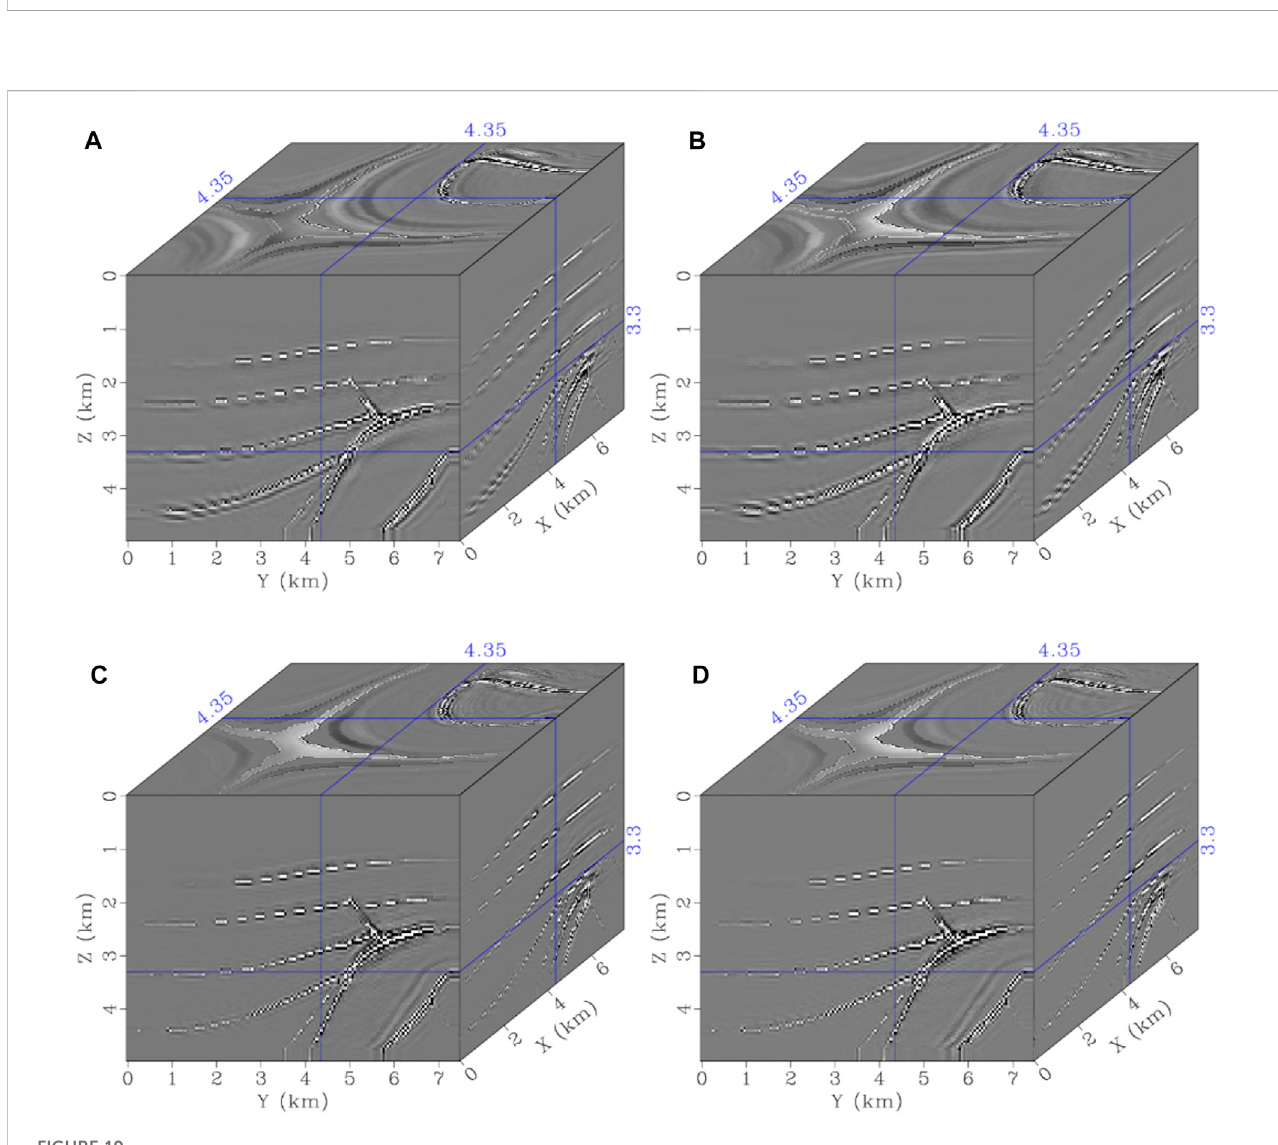
FIGURE 19 (A) and (B) PP and PS images using the STS method and (C) and (D) PP and PS images using the FTS method.